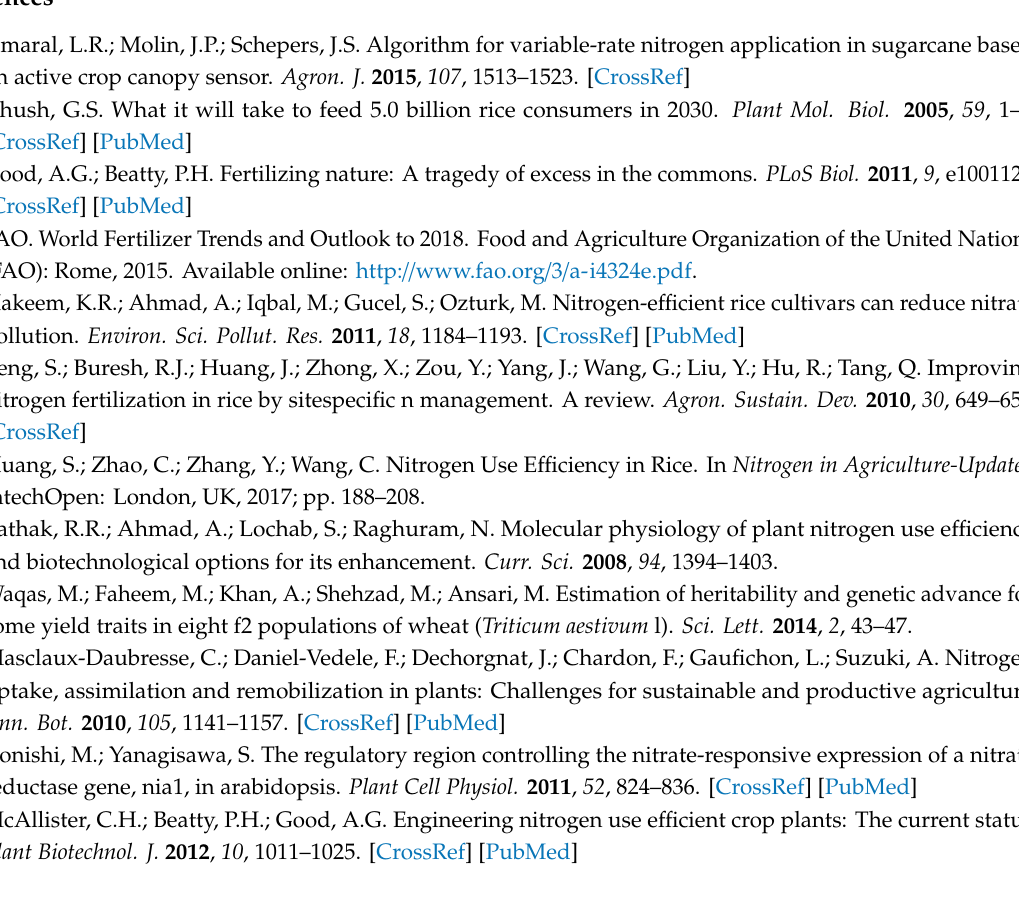
under di ff erent nitrogen treatments in bucket. Figure S4. Dry weight and root: shoot ratio of rice at di ff erent growth stages. Figure S5. Venn diagram of OTUs in rice rhizo-compartments. Figure S6. The results of principal component analysis of bacterial communities in rhizo-compartments of rice. Figure S7. Heat map of OTUs abundance of di ff erent functional bacteria in rhizo-compartments of rice under di ff erent nitrogen treatments. Figure S8. Rarefaction curves of rhizosphere, rhizoplane, and endosphere samples of rice. Table S1. Primers and conditions of OsCIPK2 and actin gene. Table S2. Morphological characteristics of roots under di ff erent nitrogen treatments in pots. Table S3. Determination of rice plant nitrogen and nitrogen utilization ratio. Table S4. Nitrogen cycle-related gene primer sequences and amplification